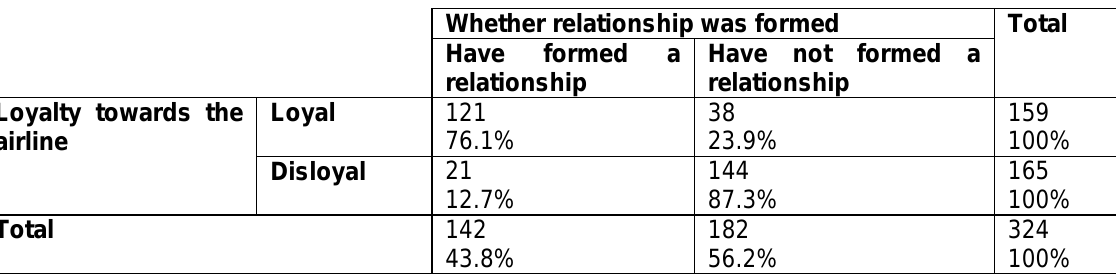
159 100% 165 100% 324